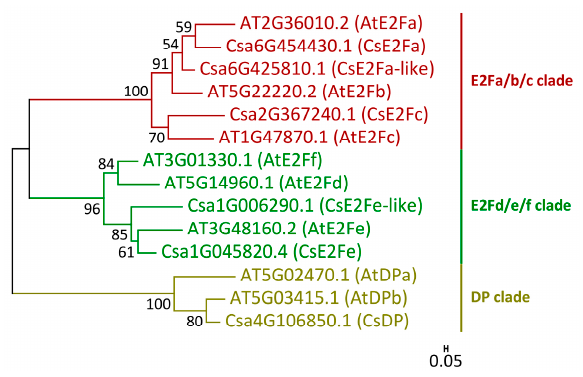
Figure 3. Phylogenetic tree of E2F/DP proteins from Arabidopsis thaliana and Cucumis sativus . The three di ff erent clades of E2F/DP proteins are presented in di ff erent colors. Gene ID pre fi xes: AT, A. thaliana based on the Arabidopsis Information Resource; Csa, C. sativus cv. Chinese Long v2 based on the Cucurbit Genomics Database v1. Scale bar: 0.05 amino acid substitutions per site.